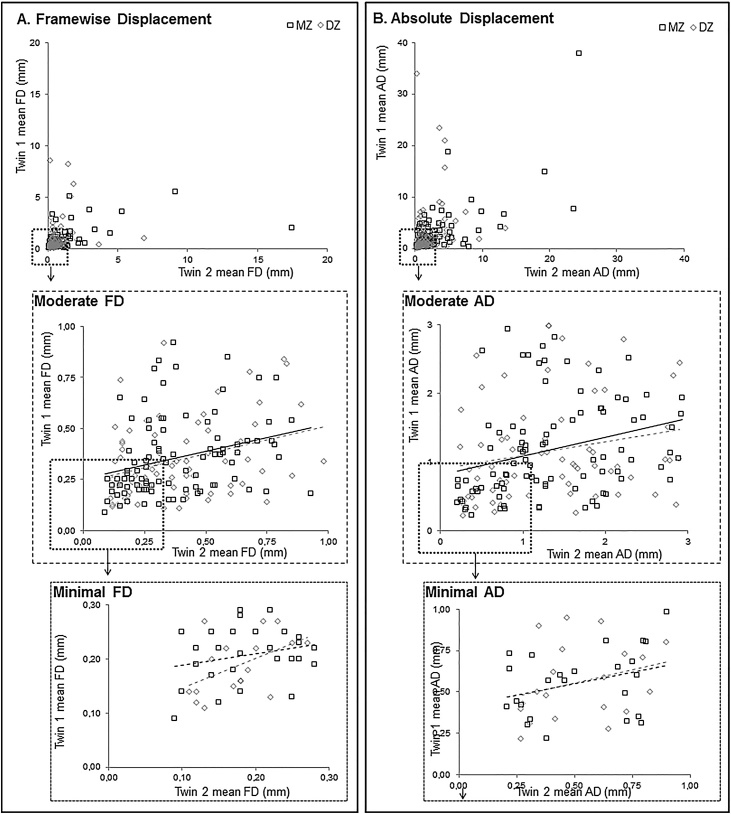
Visual representation of within-twin correlations of maximum head movement (in mm), split out by zygosity. A) Framewise head displacement in mm. The dashed frameworks are zoomed in on moderate (<1 mm mean FD) and minimal (<0.3 mm mean FD) head motion. B) Absolute head displacement in mm. The dashed frameworks are zoomed in on moderate (<3 mm mean AD) and minimal (<1 mm mean AD) head motion. Solid lines represent significant correlations (p < .001).